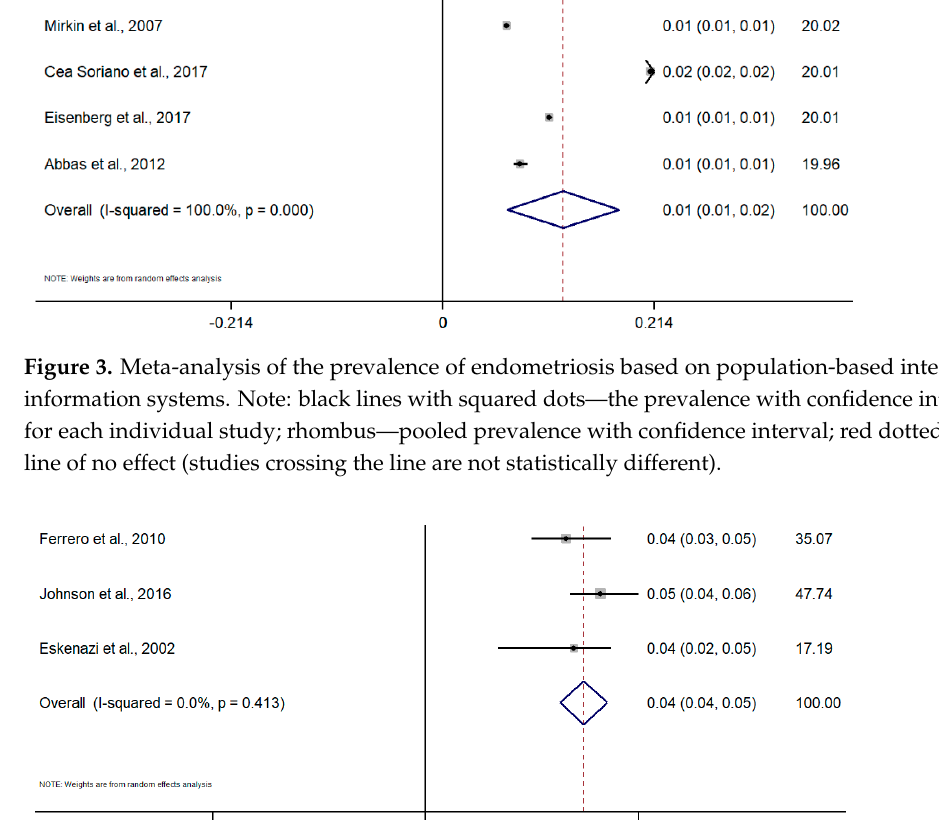
Figure 2. Meta-analysis of the prevalence of endometriosis based on self-Reported questionnaires. Note: black lines with squared dots—the prevalence with confidence intervals for each individual study; rhombus—pooled prevalence with confidence interval; red dotted line—line of no effect (studies crossing the line are not statistically different).